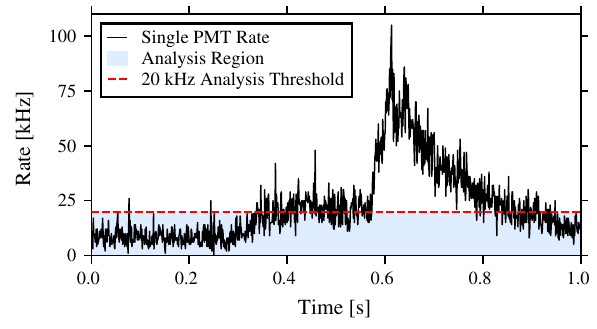
Fig. 8 One second of STRAW data showing the detection rate (black) of a single sDOM. The blue region represents the acceptable range of rates for the 40 K